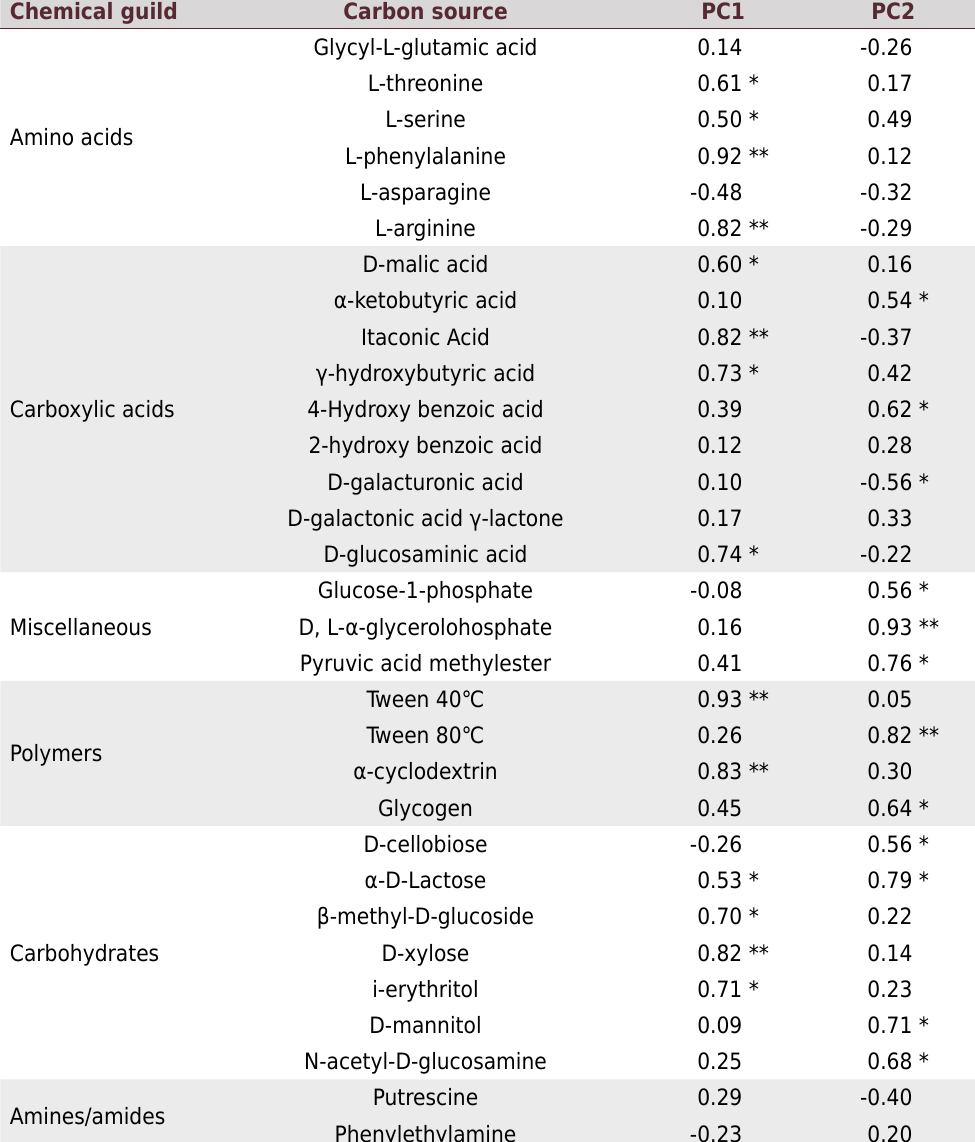
Table 4. Loading factors of principal component of 31 carbon